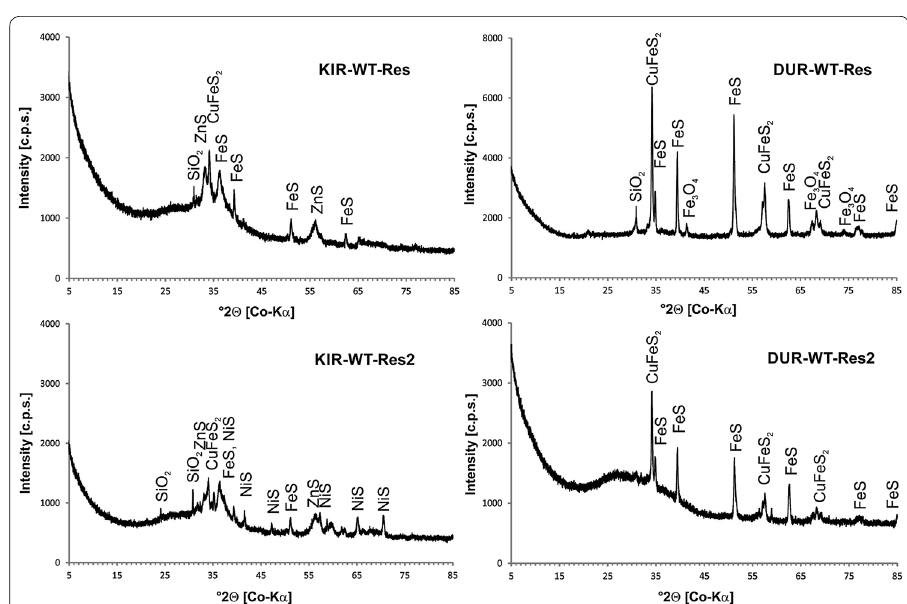
Fig. 3 Mineralogical composition of typically dark-colored KIR and DUR scale-fragment samples collected from the heat exchangers (WT) after acid digestion of the carbonate matrix based on powder XRD spectra. The black residua are mainly composed of variable metal sulfide and silica contents of variable crystallinity, i.e., FeS (pyrrhotite),